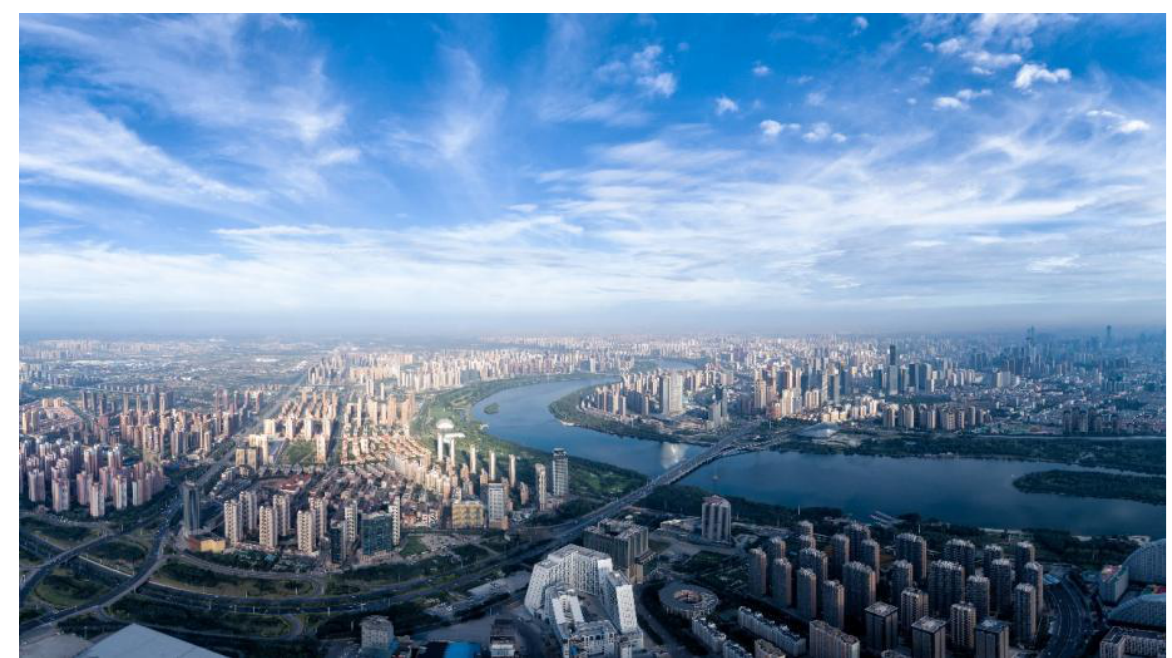
Figure 6. Sketch map of the density morphological characteristics in the study areas along the banks of Shenyang River. Source: Visual China Group.